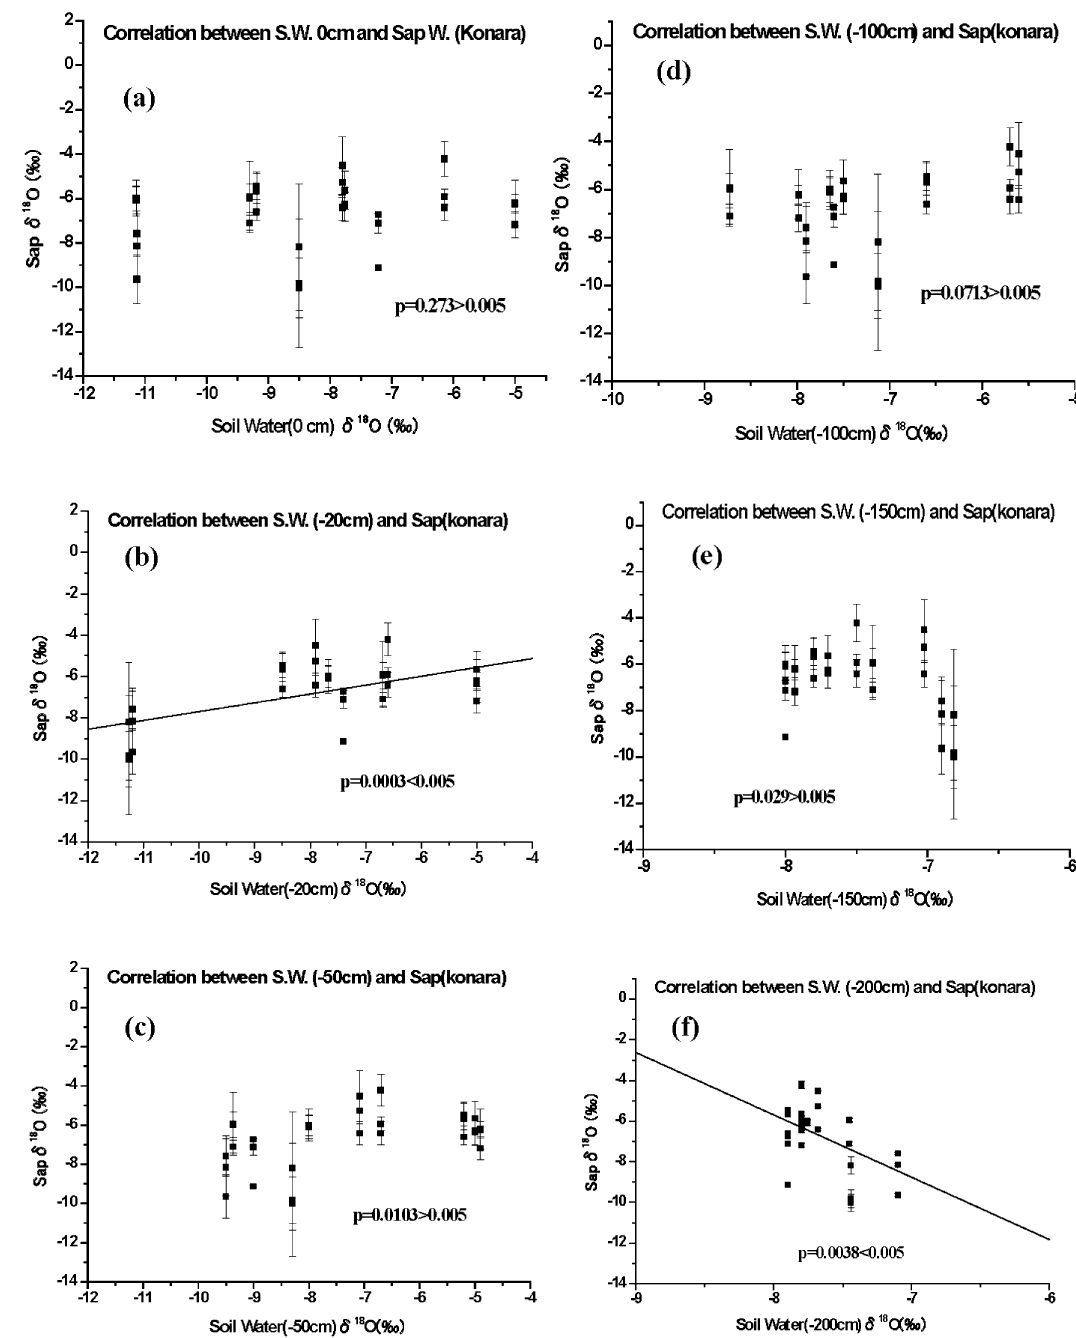
Figure 4. Relationships between soil water and sapwood sap δ 18 O values in konara trees ( n = 3). ( a ) Rainwater collected at a depth of 0 cm and ( b – f ) soil water collected at depths of ( b ) 20 cm, ( c ) 50 cm, ( d ) 100 cm, ( e ) 150 cm, and ( f ) 200 of 200 cm ( P = 0.0032 < 0.005). In addition, the F -test results suggest that there was no significant relationship between heartwood sap and soil water δ 18 O values at any depth (Supplementary Table S5). Diffusion coefficients for D O, K + , Cs + , and I − for stem xylem of sugi. We measured the diffusion 2 coefficients for D 2 O, K + , Cs + , and I − in the sapwood and heartwood samples from the sugi trees at room tempera- ture (20 °C) from 1 to 10 months after labeling (Table 1). The average estimated diffusion coefficients for D 2 O were 2.8 ± 0.007 × 10 −10 m 2 s −1 for sapwood and 2.2 ± 0.9 × 10 −10 m 2 s −1 for heartwood (except for the heartwood-1 sample with a visible ray parenchyma). Those for K + and Cs + were 0.9 ± 0.03 × 10 −10 m 2 s −1 and 0.53 × 10 −10 m 2 s −1 , respectively, for sapwood and 1 ± 0.005 × 10 −10